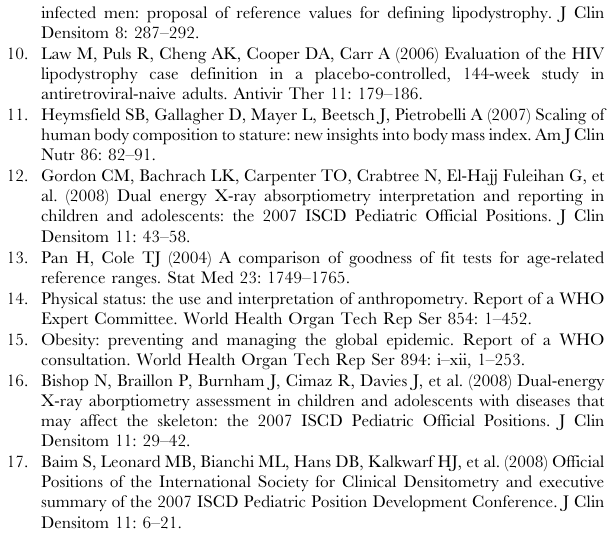
Table S14 Sub-total Body BMC (g) vs. Age in pediatric subjects. DOC) Table S15 Total Body BMD (g/cm 2 ) vs. Height (cm) in pediatric subjects. DOC) Table S16 Total Body BMC (g) vs. Height (cm) in pediatric subjects. DOC) Table S17 Sub-total Body BMD (g/cm 2 ) vs. Height (cm) in pediatric subjects. DOC) Table S18 Sub-total BMC (g) vs. Height (cm) in pediatric subjects. DOC) Table S19 Total Lean Mass (g) vs. Height (cm) in pediatric subjects. DOC) Table S20 sub-total BMC (g) vs. Total Lean Mass (g) in pediatric